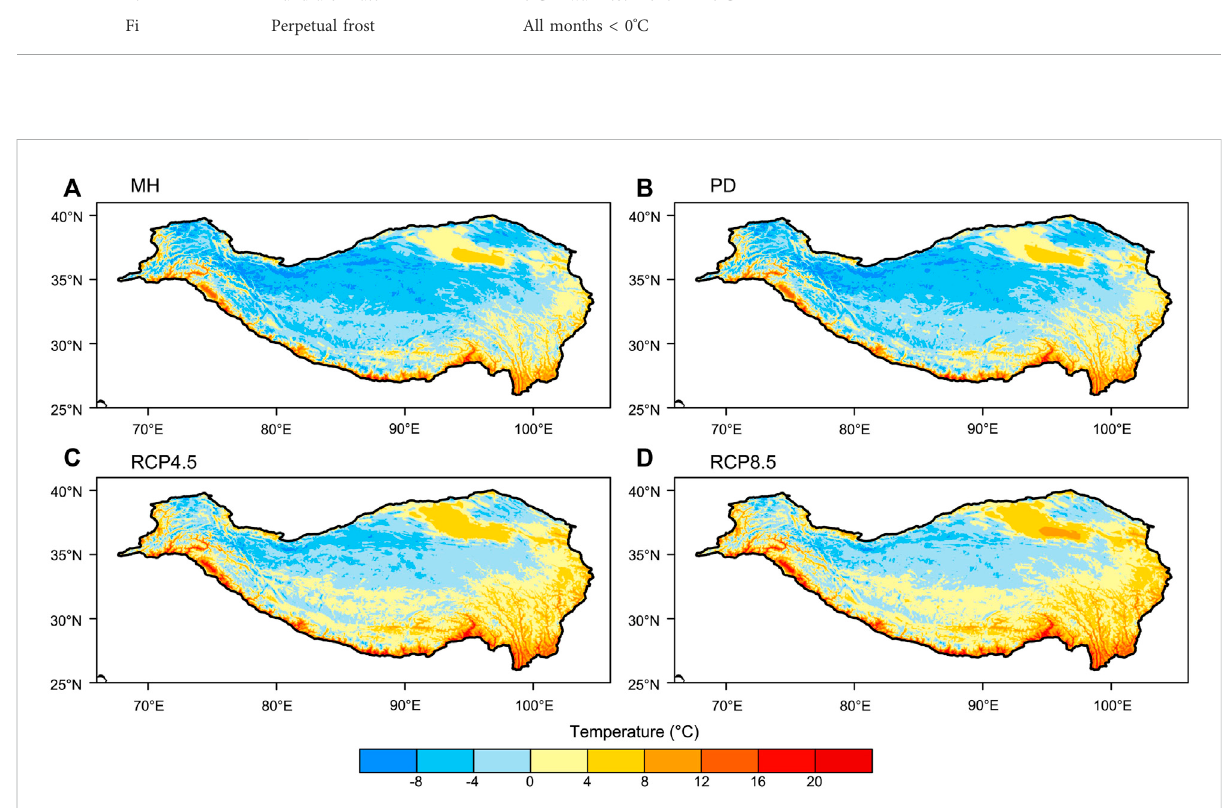
FIGURE 3 Distribution of average annual temperature (units: ° C) across TP in the (A) MH, refers to ~6 cal ka BP; (B) PD, refers to 1960 – 1990; (C) RCP4.5, (D) RCP8.5, refers to the average for 2041 – 2060.